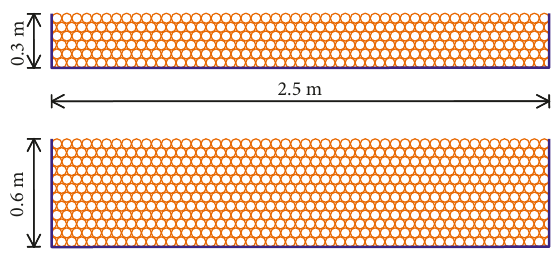
Figure 2: Used thicknesses of pebble